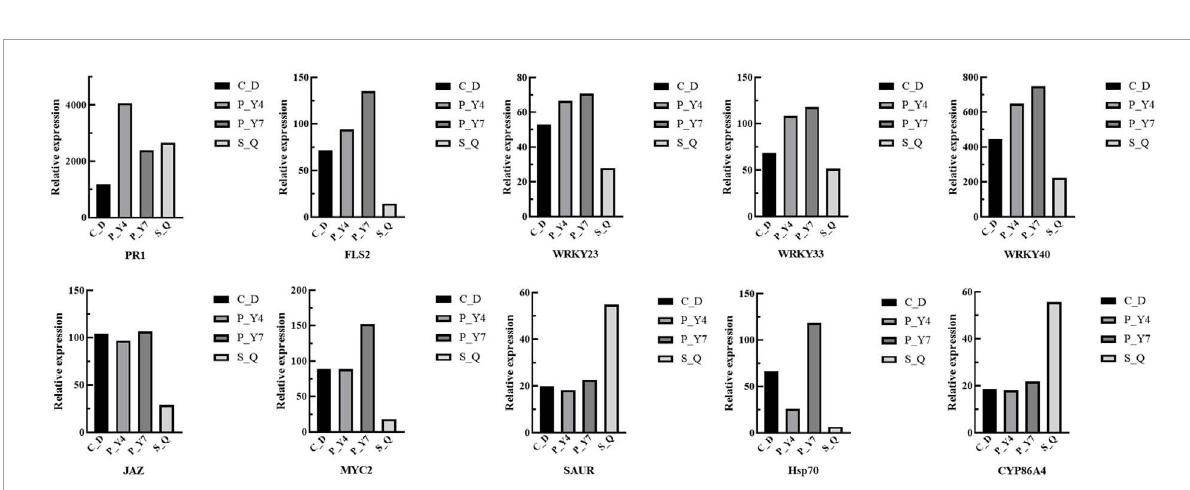
FIGURE10 The gene expression was evaluated by qRT-PCR analysis to validate the RNA-seq